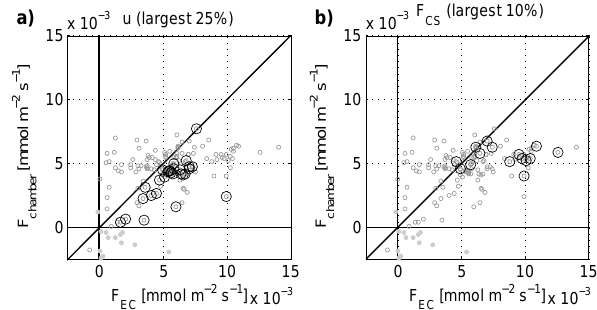
Fig. 5. Scatterplot sections of EC- and chamber-determined NEE under particular micrometeorological conditions: (a) largest 25% of the wind velocities ( u >2.9ms − 1 ) ; (b) largest 10% of the fluxes due to coherent structures ( F CS >: 0.0015mmolm − 2 s − 1 ) – la- beled with large black circles in each case: light grey circles rep- resent fluxes with different